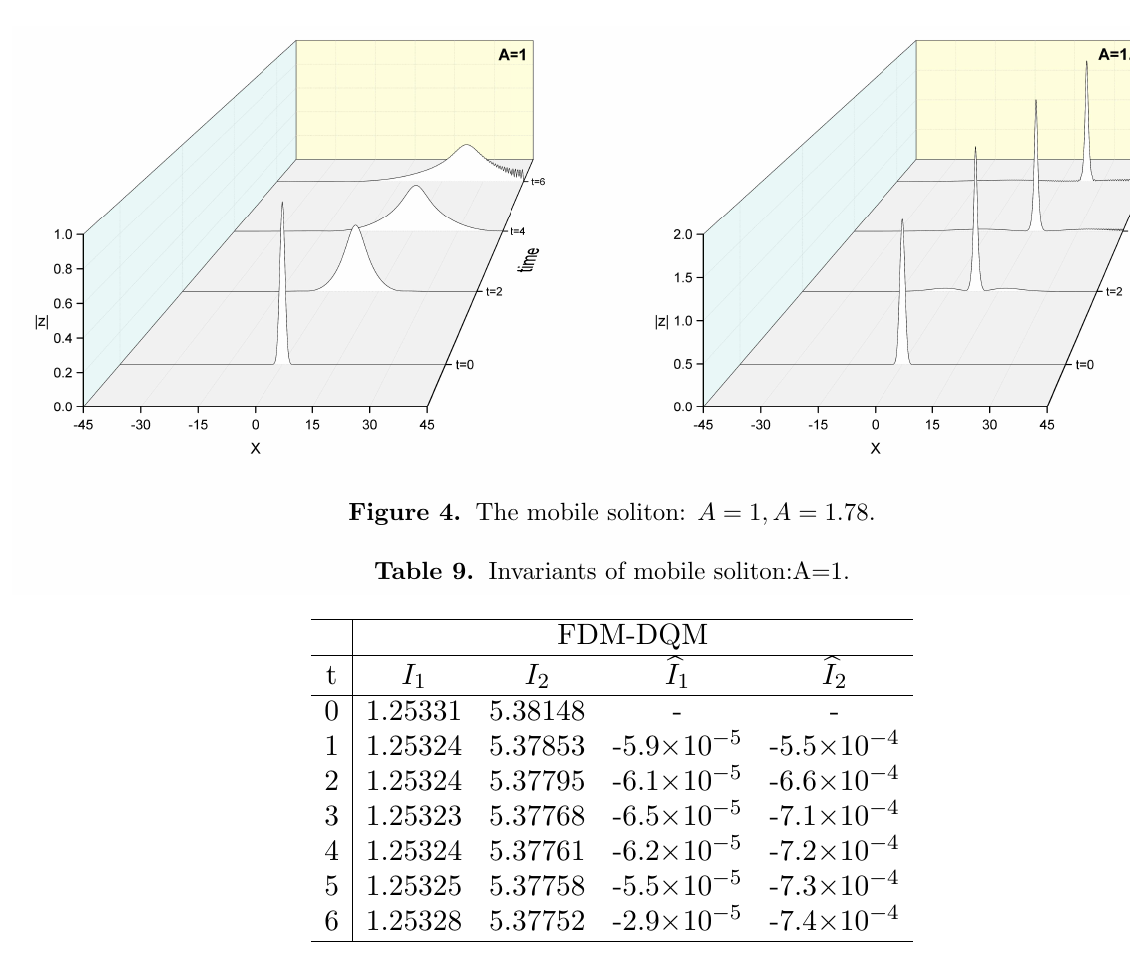
Table 10. Invariants of mobile soliton:A=1.78 Quin. Coll.